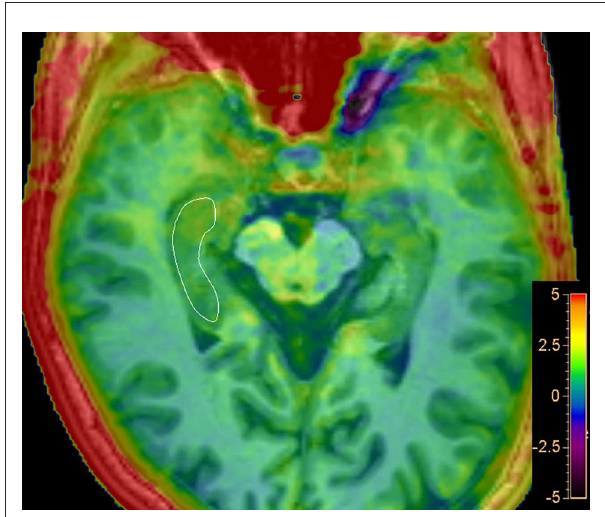
FIGURE2 Representative regions of interest (ROIs) for APT analysis. Delineate ROI of the right hippocampus in the maximum cross-sectional layer of T 1 -weighted image with APTw image overlay.